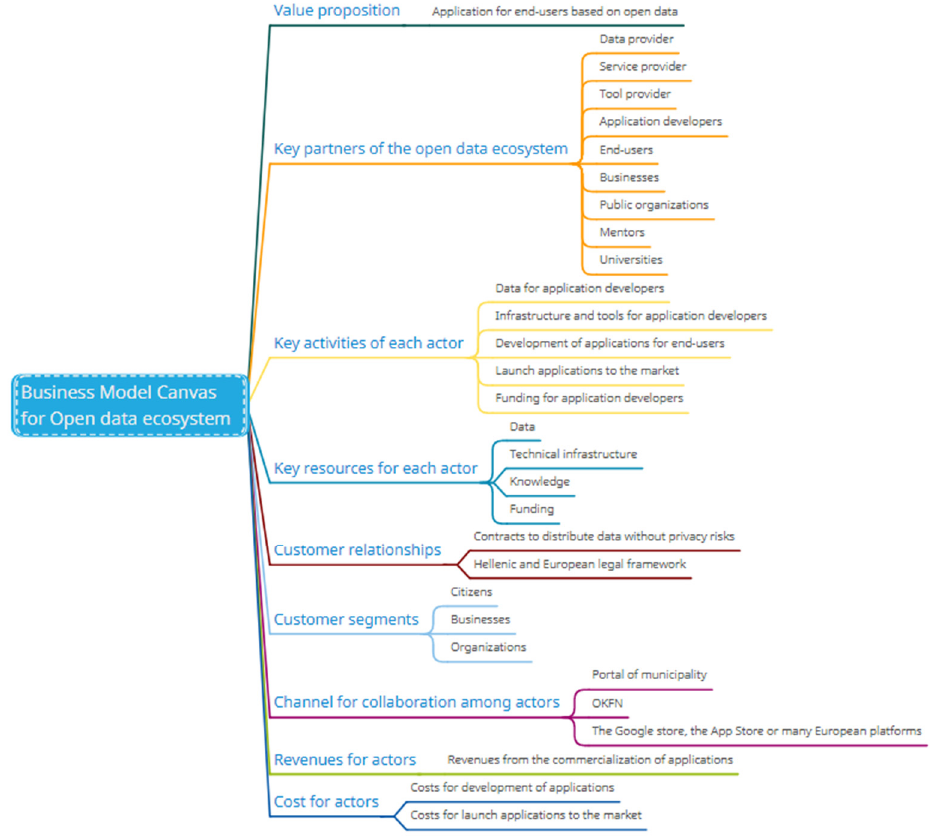
Figure 4. Mind map visualization for business model canvas for open data ecosystem.